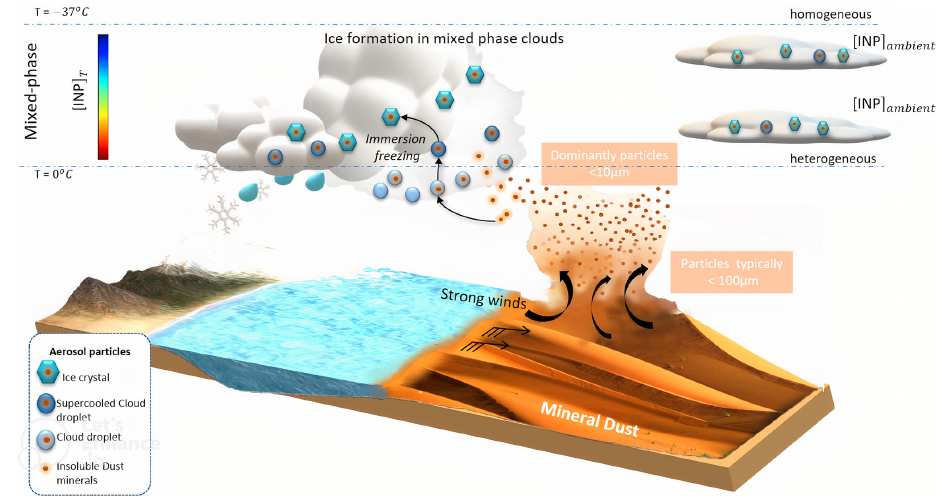
Figure 1. Illustration of the formation of INPs from mineral dust aerosols and the two ways in which we display INP concentrations in the present study: [INP] ambient , calculated at ambient model temperature relevant to non-deep convective mixed-phase clouds using the ambient temperature in the model temperature level (right part of the figure), and [INP] T , calculated at a fixed temperature relevant for vertically extended clouds such as deep-convective systems (left part of the figure). The temperature color scale from 0 to − 37 ◦ C is provided to the left (see text). The figure is modified by combining the ones in Kanji et al. (2017) (Fig. 1), Harrison et al. (2019) (Fig. 1), and Vergara- Temprado et al. (2017) (Fig. 3).